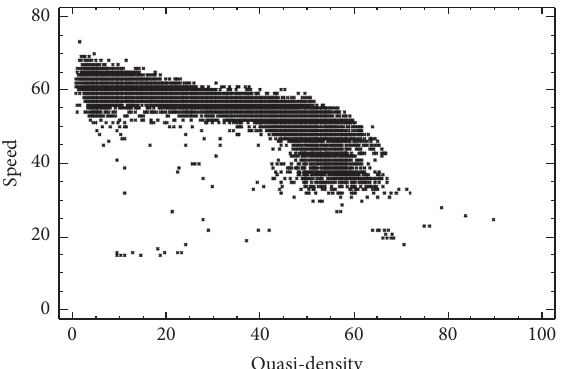
Figure 7: Speed (km/h) against quasi-density